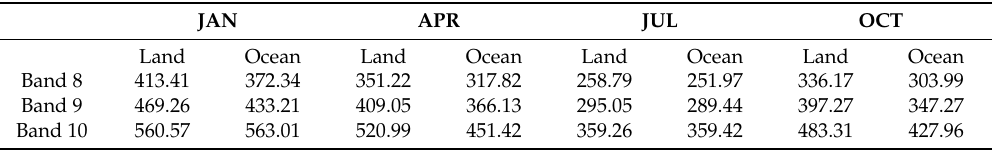
Table 2. The mean P over land and ocean in January, April, July and October of Band 8, Band 9 and Band 10. Units are hPa.